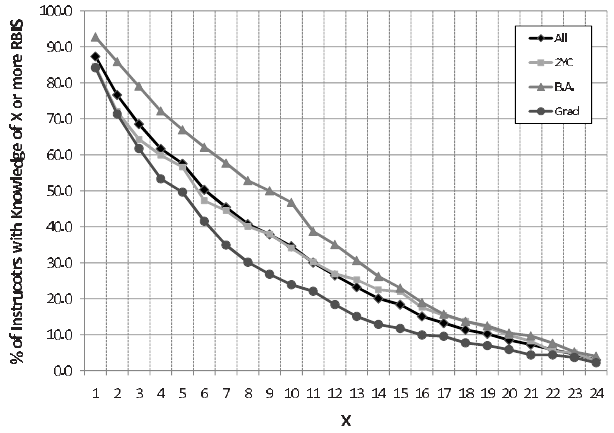
FIG. 2. Percentage of instructors who know about X or more RBIS.